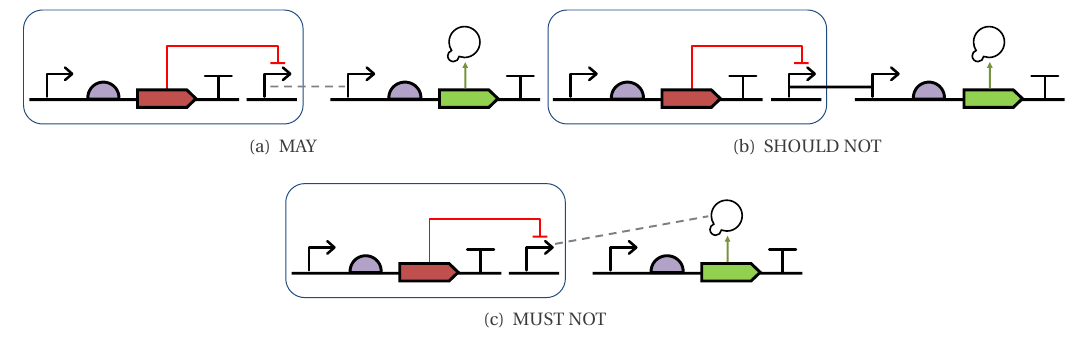
Figure 24: Examples of recommended and problematic mappings: (a) mapping showing that the promoter inside the module on the left is also used in the construct on the right, (b) mapping is not visually distinct from nucleic acid backbone, (c) mapping cannot identify a promoter with a macromolecule species.